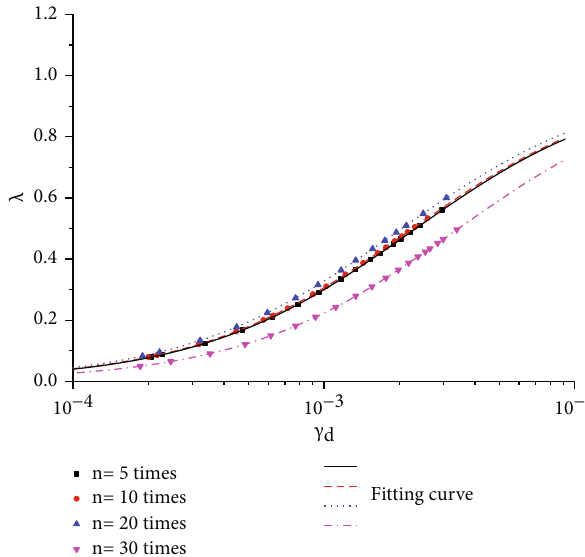
Figure 16: Damping ratio-strain curves under di ff erent freeze-thaw cycles (-5 ° C).